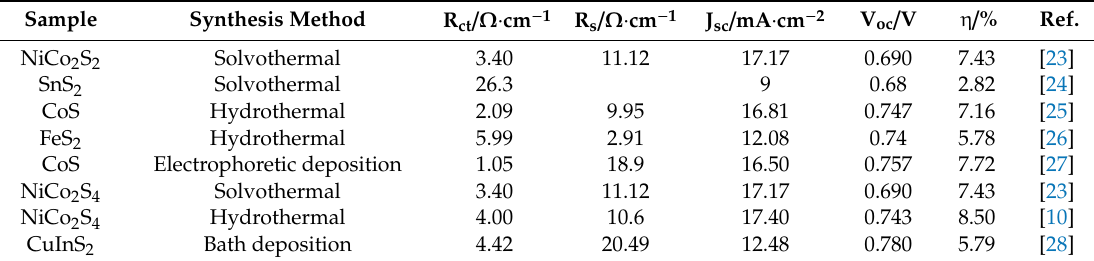
Table 1. Photovoltaic parameters of various binary sulphide counter electrodes.